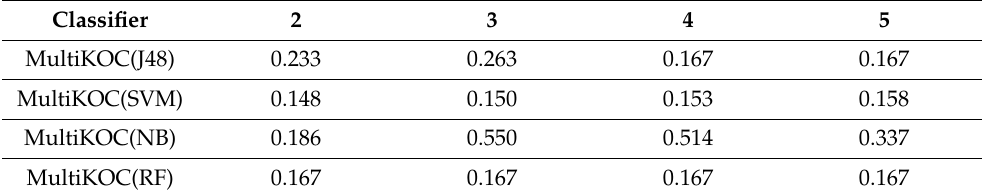
Table 7. Results summary for MultiKOC method with 2, 3, 4, 5 clusters on Synthetic data.